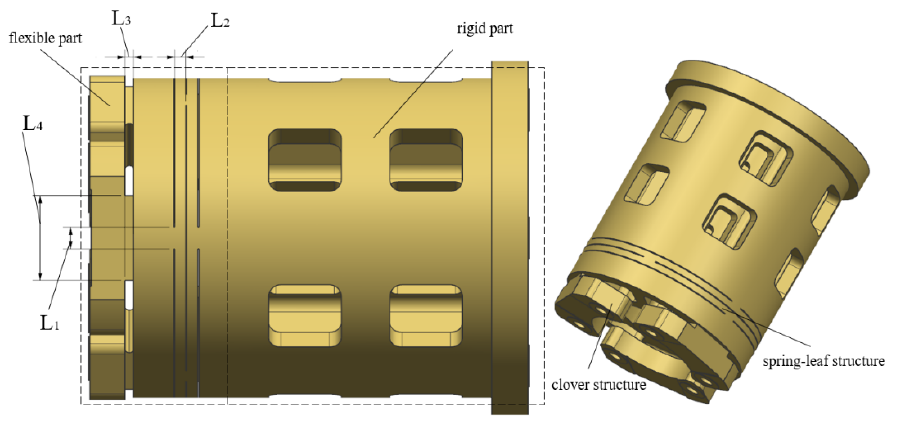
Figure 4. Flexible support structure.